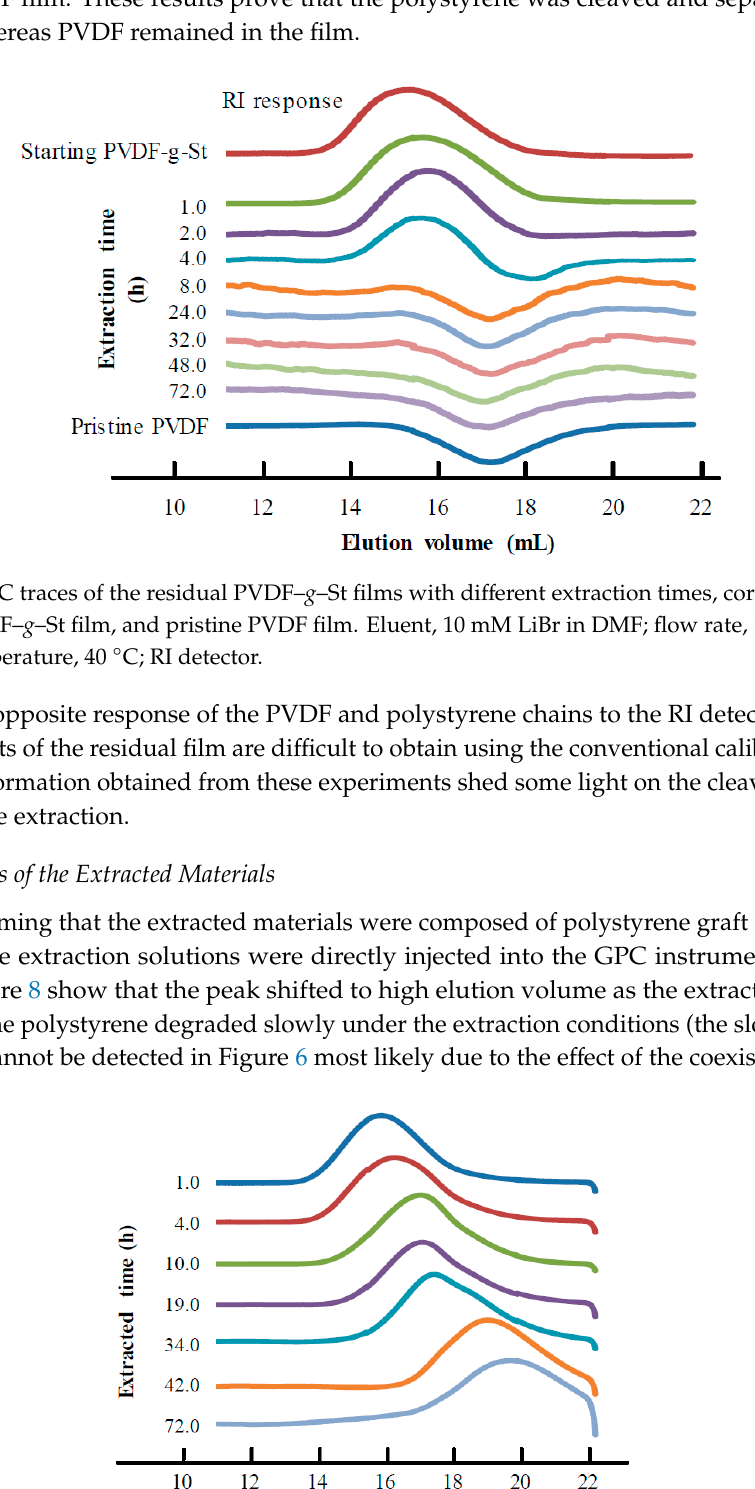
Figure 8. GPC traces of the extracted polystyrene graft chains obtained with different extraction times. GPC conditions: eluent, 10 mM LiBr in DMF; flow rate, 1.0 mL/min; column temperature, 40 ° C; RI detector.